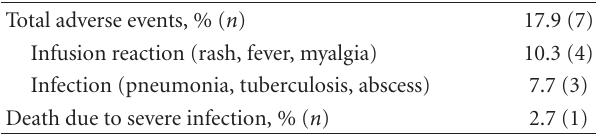
Figure 1: Response at 6 months after RTX treatment in patients with refractory SLE.